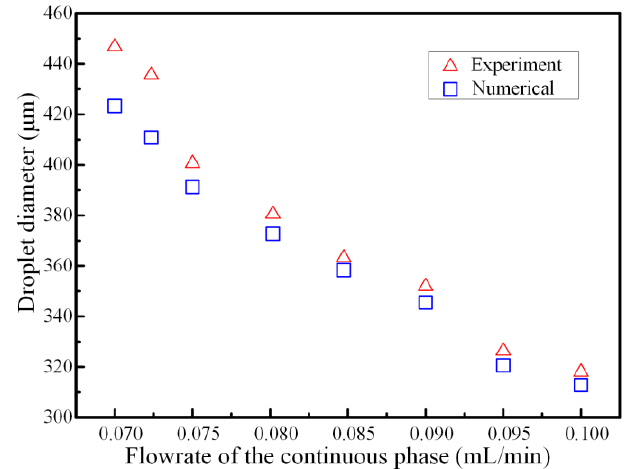
Figure 5. Comparison of the droplet diameter between numerical simulations and experimental results for different flowrates of continuous phase when the flowrate of dispersed phase was fixed as 10 μL/min .